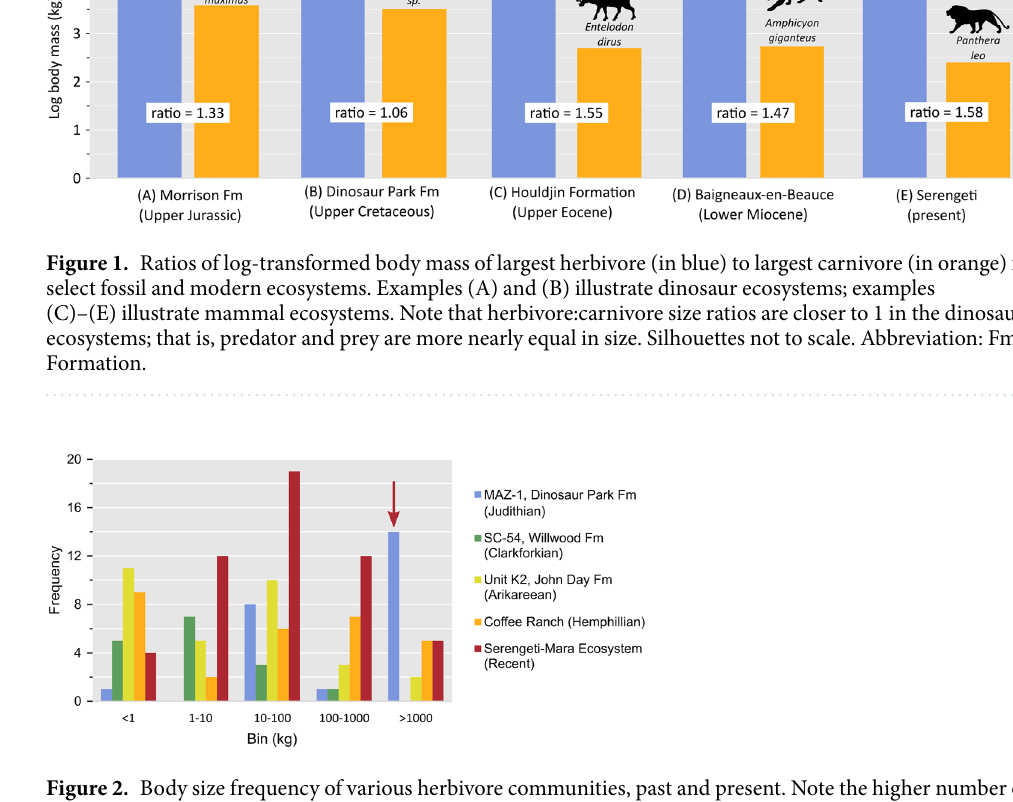
Figure 2. Body size frequency of various herbivore communities, past and present. Note the higher number of megaherbivores ( > 1,000 kg) in the Dinosaur Park Formation (indicated by red arrow) relative to the mammal assemblages. Data from 26,195–200 . Abbreviation: Fm,